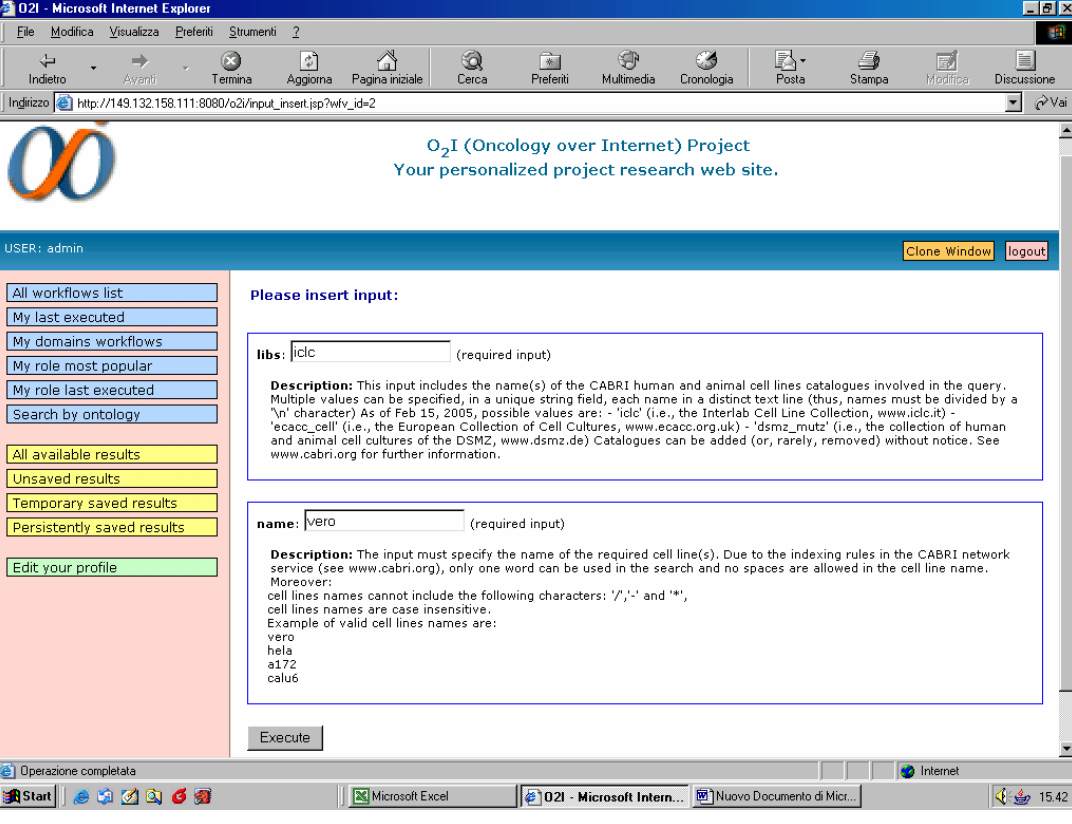
Figure 4: Input form for the execution of a workflow. The description of the input includes some examples. Inputs that are mandatory for the execution of the workflow are pointed